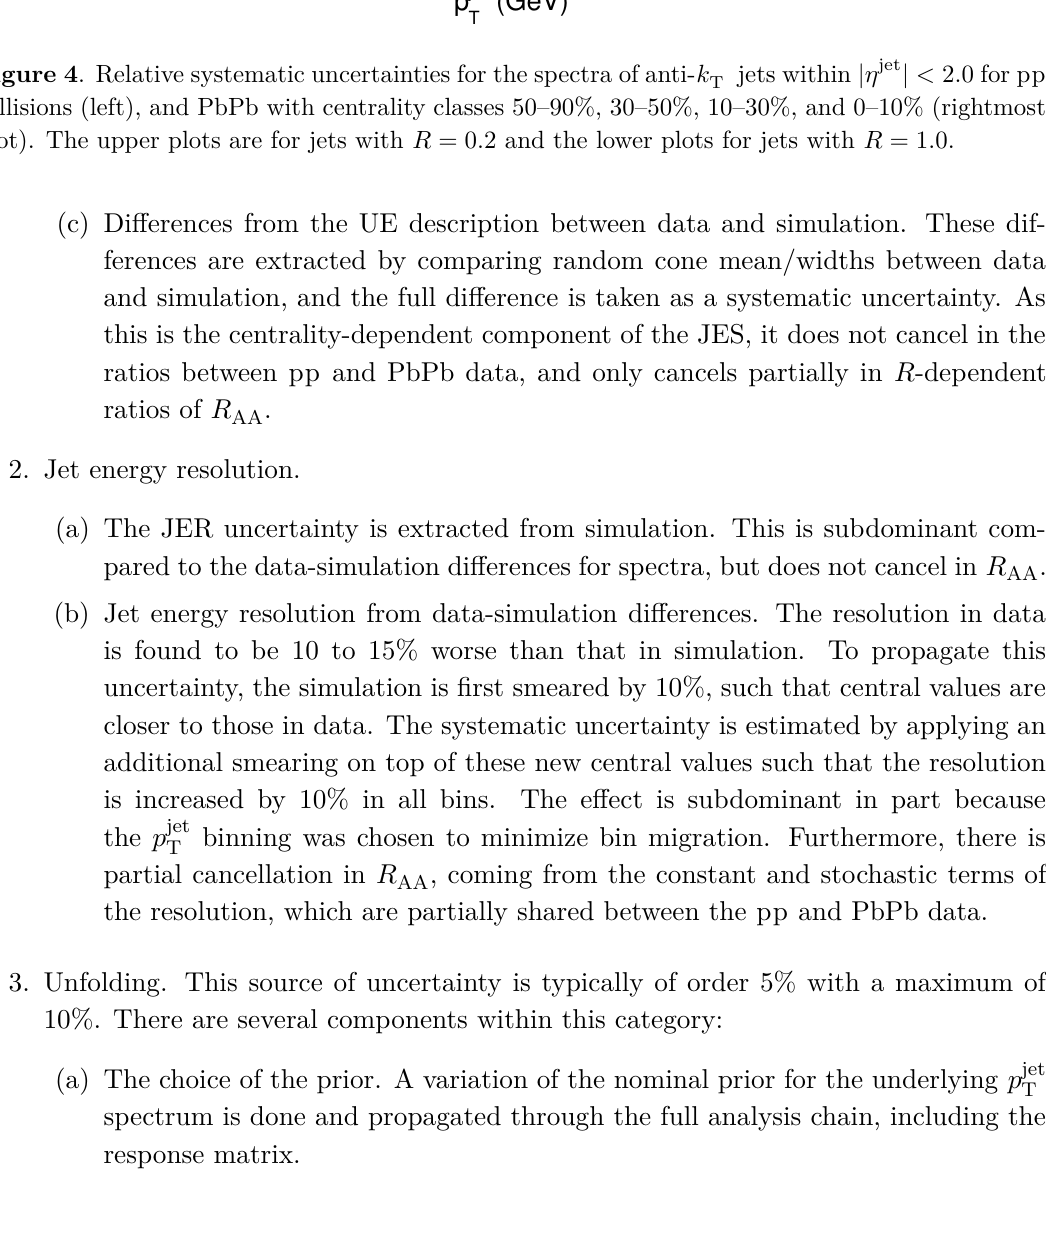
jets within | η jet | < 2 . 0 for pp T